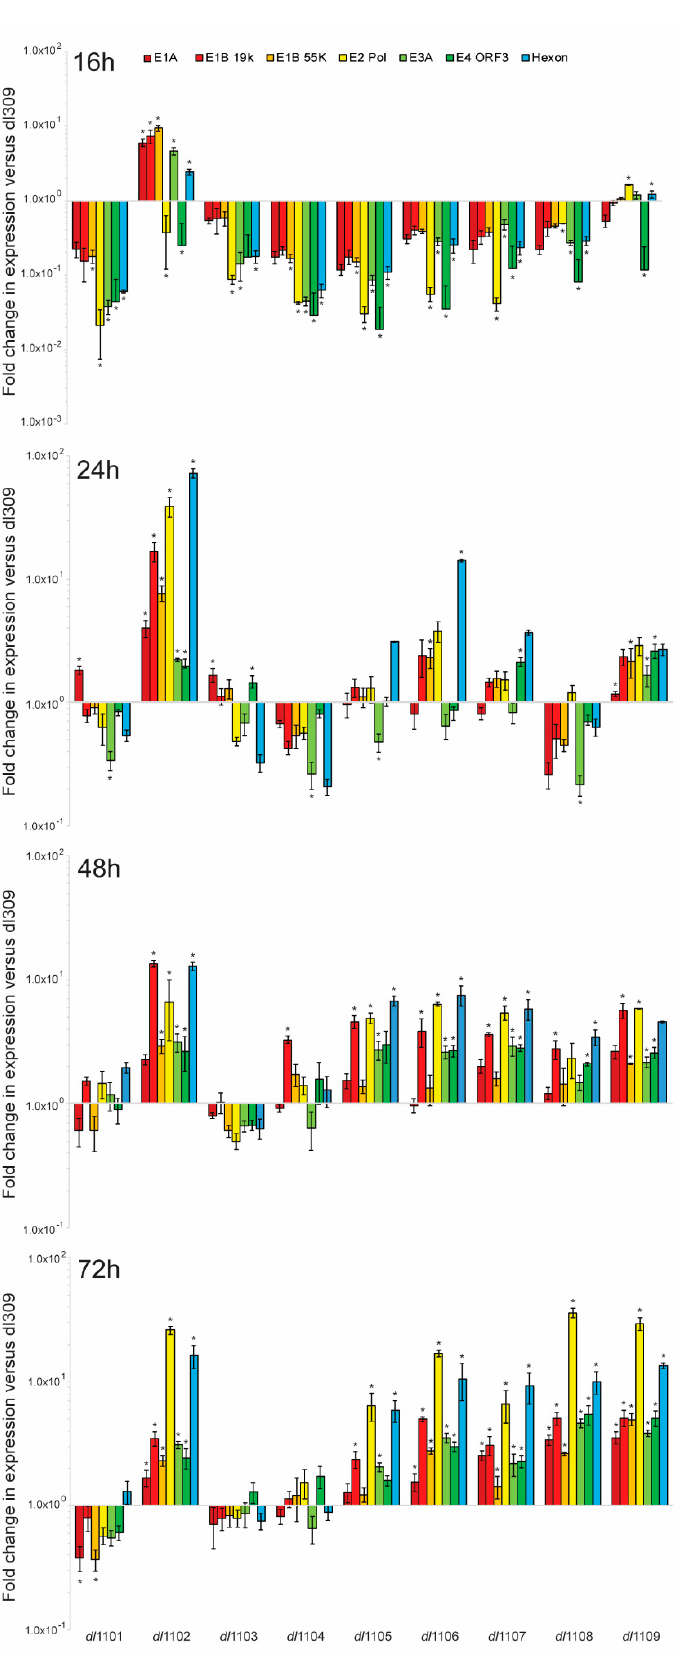
Figure 5. Expression of viral genes from E1A exon 1 mutants relative to dl 309 in arrested WI-38 cells. WI-38 cells were grown until confluence at which point medium was replaced and cells were incubated for 72 h before infection with the indicated viruses at a MOI of 100. At the specified time ‐